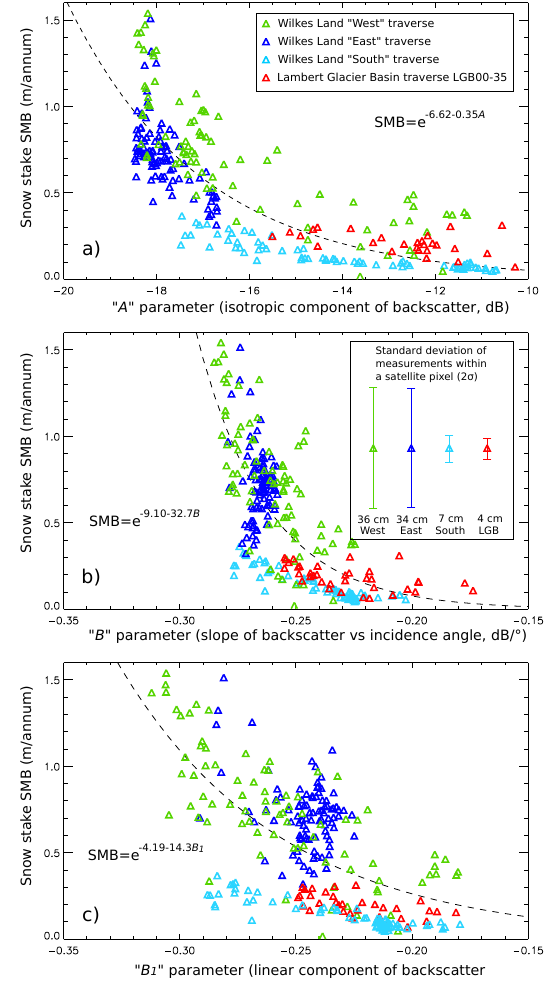
Figure 2: a) SMB vs “ A ” parameter for the linear parameterisa- tion (cubic is very similar, so not shown here). b) SMB vs “ B ” parameter for the linear parameterisation. c) SMB vs “ B 1 param- eter for the cubic parameterisation. The least-squares fit using a model of the form SMB = e a − bx is shown with the dashed line, where x is the “ A ” parameter for panel a), “ B ” for b), and “ B 1 ” for c), after Drinkwater et al. (2001) in